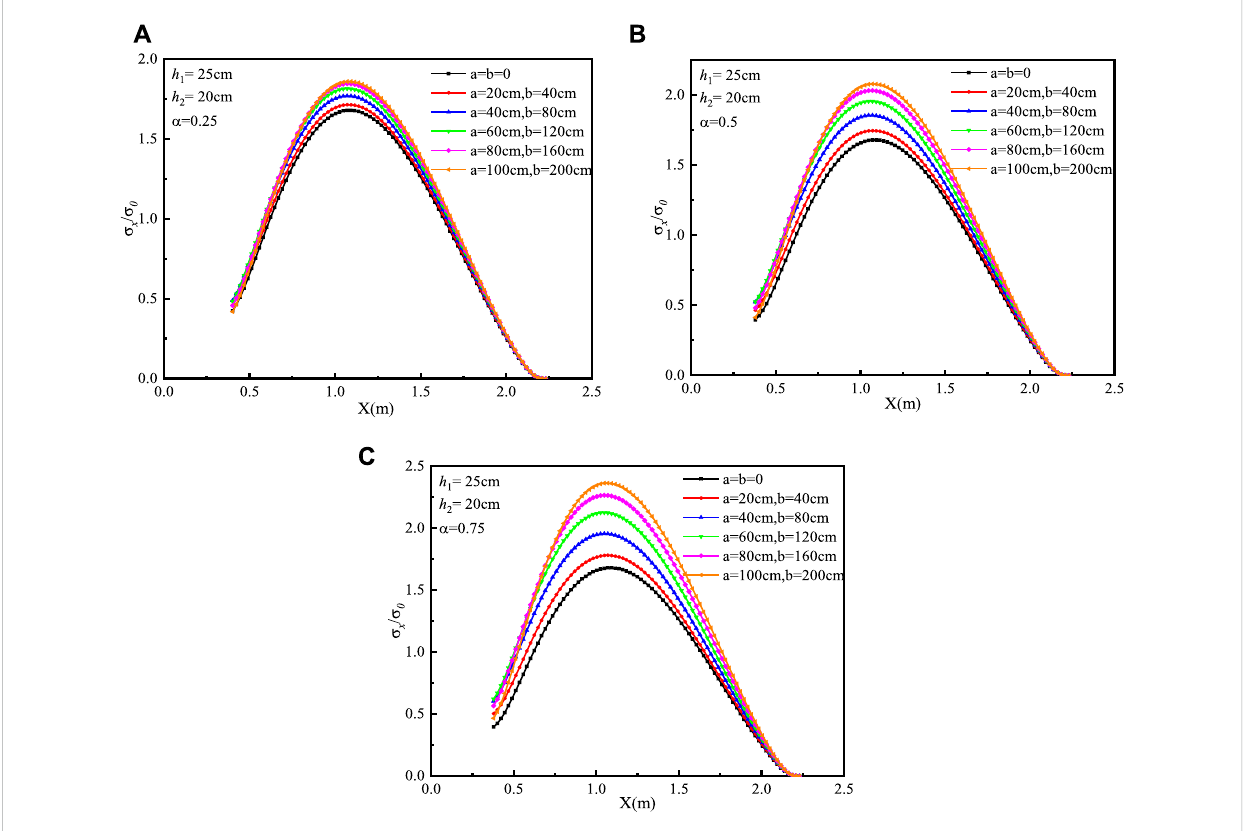
FIGURE 8 Dimensionless tensile stress distribution of the pavement using the FEM with h 1 = 25 cm and h 2 = 20 cm: (A) α = 0.25, (B) α = 0.5, and (C) α =